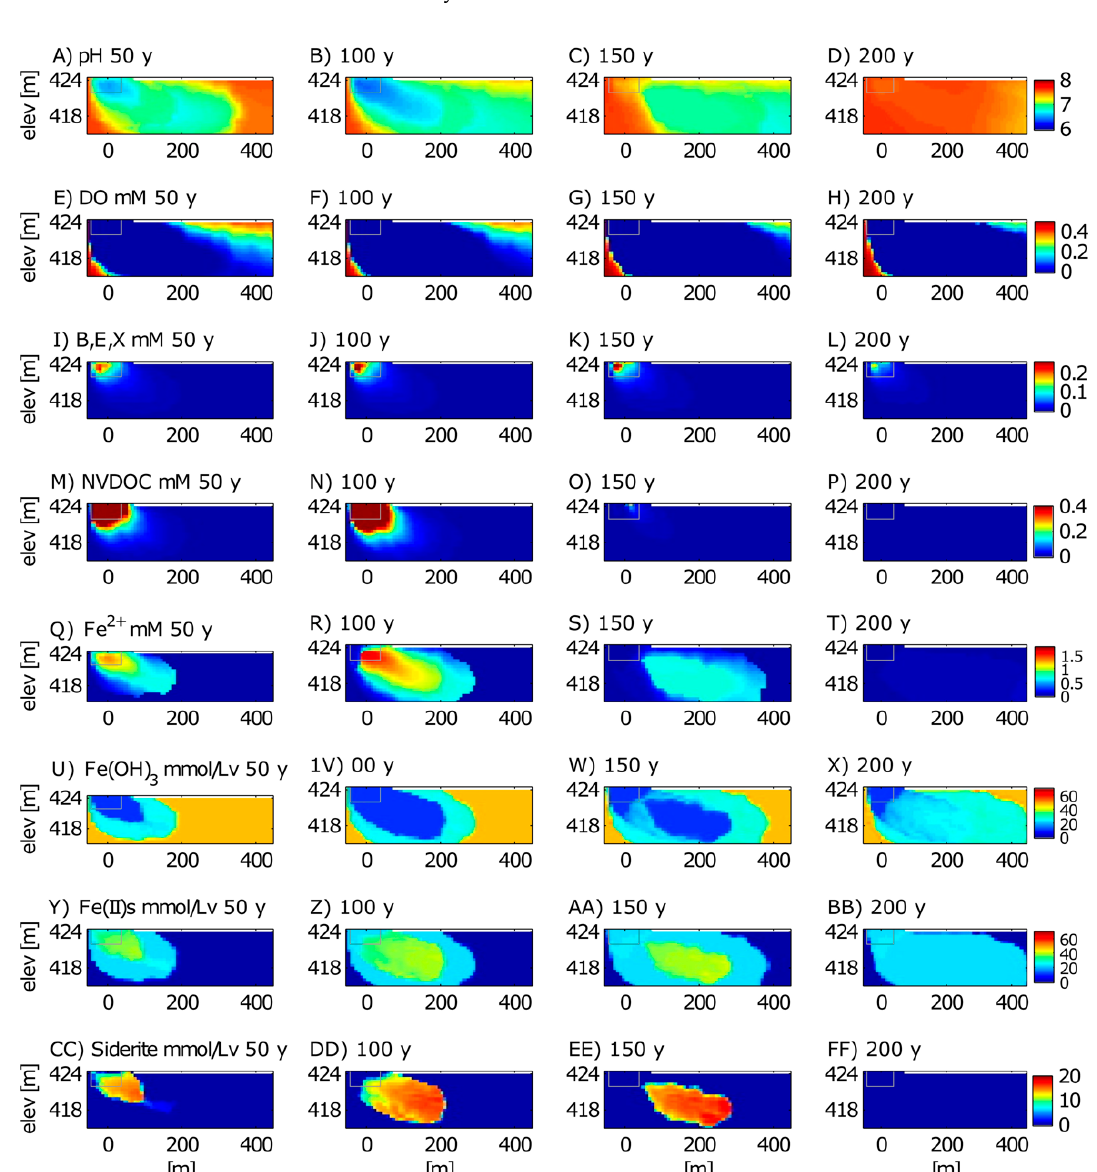
Figure 6. Model simulation results for selected species for the time periods of 50 years (2029), 100 years (2079), 150 years (2129), and 200 years (2179) after the spill. Modeled species include pH ( A – D ), DO ( E – H ), cumulative benzene, ethylbenzene, and xylene (BEX) ( I – L ), non-volatile dissolved organic carbon (NVDOC) ( M – P ), Fe 2+ ( Q – T ), Fe(OH) 3 ( U – X ), sorbed Fe(II) ( Y – BB ), and siderite (FeCO 3 ) ( CC – FF ). The gray box is the reference for the extent of the oil body. The top boundary is the water table.